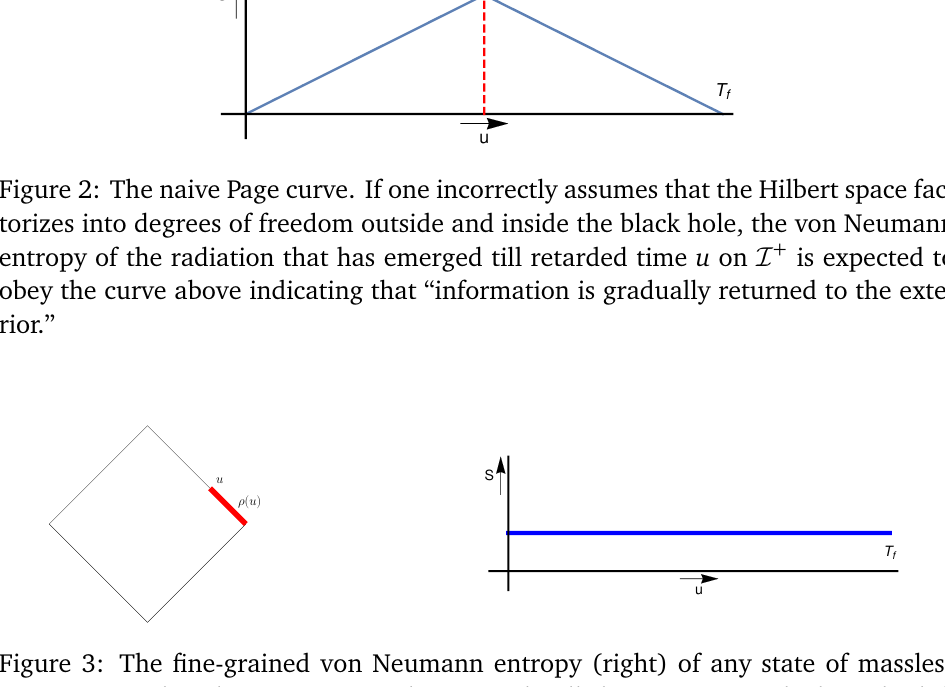
Figure 3: The fine-grained von Neumann entropy (right) of any state of massless excitations reduced on a segment that extends till the cut at u marked on the left figure. The result directly follows from the arguments above. The information is always outside, and so the entropy never goes up or comes